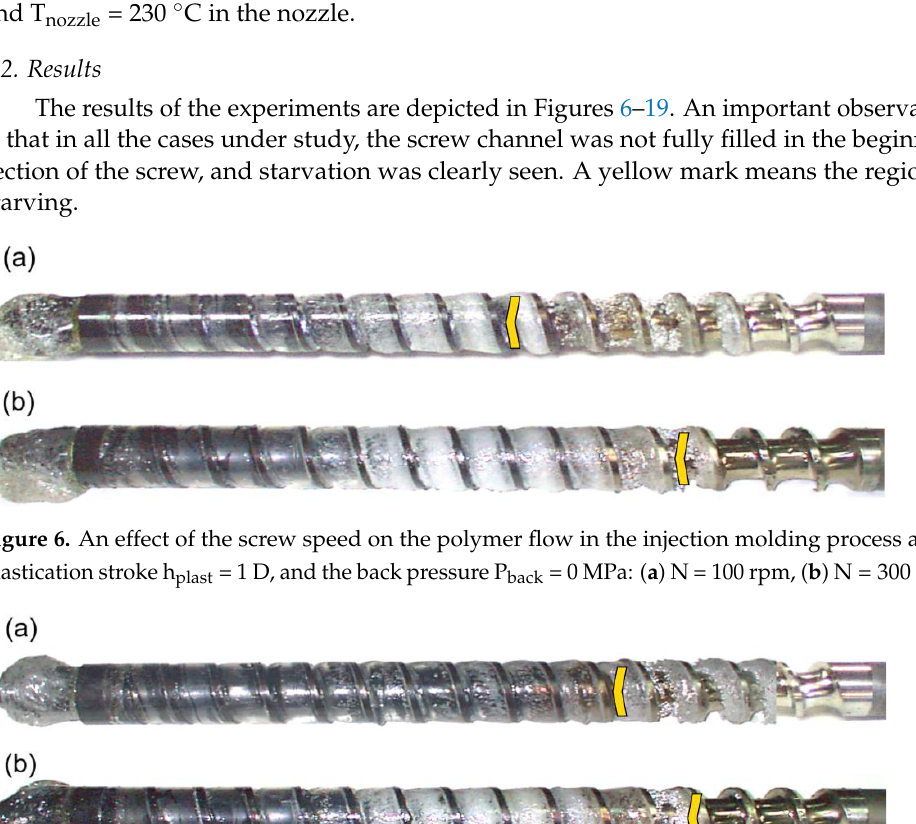
Figure 8. An effect of the screw speed on the polymer flow in the injection molding process at the plastication stroke h plast = 3 D, and the back pressure P back = 0 MPa: ( a ) N = 100 rpm, ( b ) N = 300 rpm. Figure 9. An effect of the screw speed on the polymer flow in the injection molding process at the plastication stroke h plast = 3 D, and the back pressure P back = 2 MPa: ( a ) N = 100 rpm, ( b ) N = 300 rpm. Figure 10. An effect of the screw speed on the polymer flow in the injection molding process at the plastication stroke h plast = 3 D, and the back pressure P back = 3 MPa: (a) N = 100 rpm, (b) N = 300 rpm. An effect of the plastication stroke (h plast = 1 D, h plast = 3 D) on the polymer flow in the injection molding process at the constant screw speed and the constant back pressure is shown in Figures 11 – 15. It is seen that when the plastication stroke increases, the starva- tion increases, too.